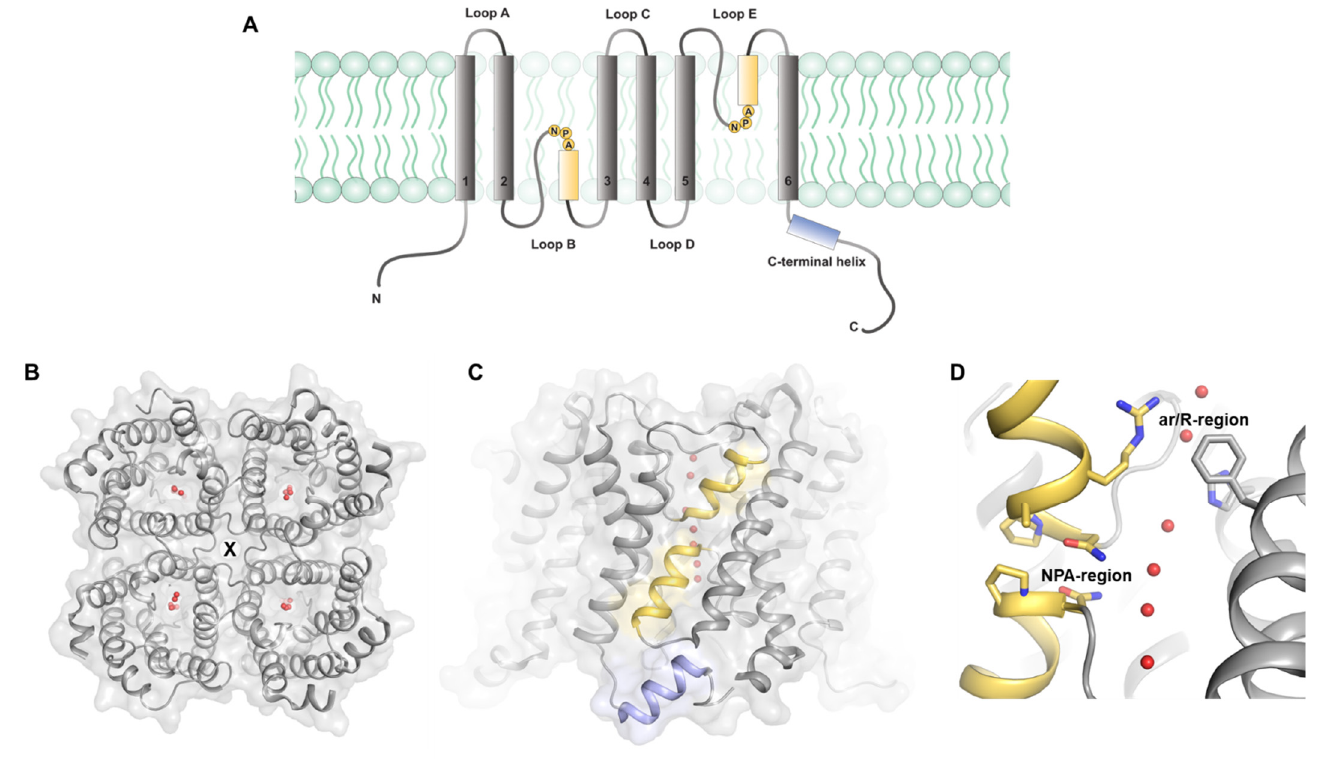
Figure 1. Structural features of mammalian AQPs. ( A ) Schematic representation of the mammalian AQP topology. Each monomer comprises six transmembrane helices (I–IV) connected by five loops (A–E). Loops B and E fold back into the membrane, forming two half-membrane spanning helices (highlighted in yellow) that harbor the two asparagine–proline–alanine (NPA) motifs. The N- and C-termini are located in the cytoplasm, with the C-terminus typically forming a short amphipathic helix (highlighted in blue) that is a common protein–protein interaction site. ( B ) Crystal structure of the AQP5 tetramer viewed from the cytoplasmic side (PDB code 3D9S), showing the four individual water channels formed by the monomers with water molecules drawn as red spheres. The central channel through the middle of the tetramer is indicated with an X. ( C ) Crystal structure of the AQP5-tetramer viewed from the side of the membrane. The loop B and E half-membrane spanning helices and the C-terminal helix are colored yellow and blue, respectively. ( D ) Zoom-in on the water- conducting channel where water molecules line up in a single file. Residues in the aromatic–arginine (ar/R) and asparagine–proline–alanine (NPA) regions are shown in stick representation. The two half-membrane spanning helices are colored